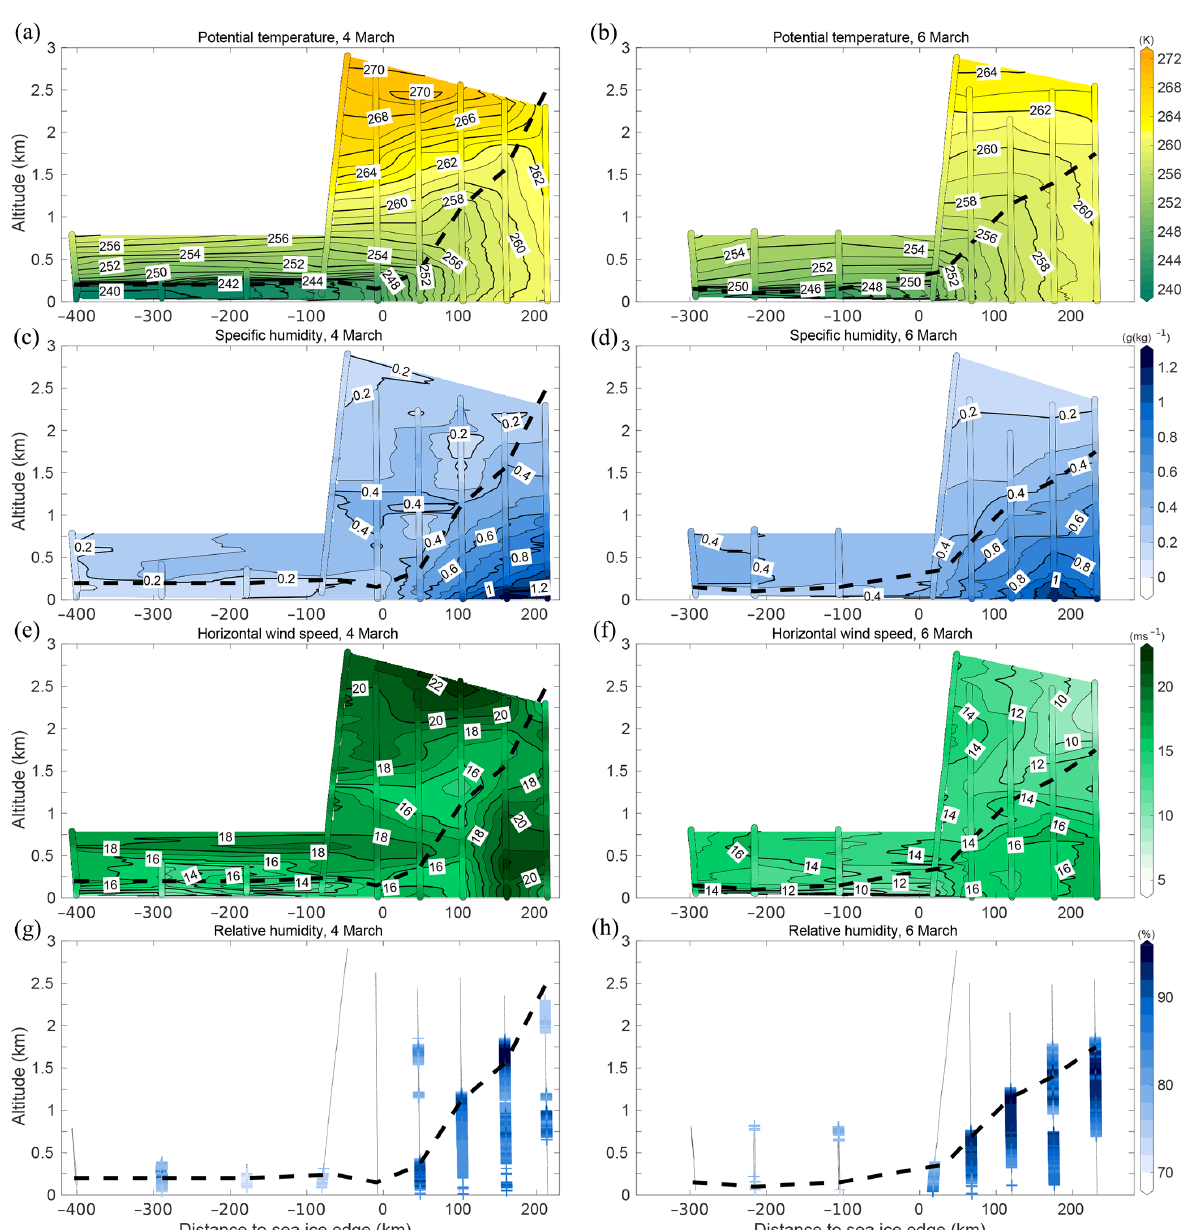
Figure 6. Vertical cross sections of (a–b) potential temperature, (c–d) specific humidity, (e–f) horizontal wind speed, and (g–h) relative humidity in saturated areas with respect to an ice surface for (a, c, e, g) 4 March and (b, d, f, h) 6 March 2013 based on the quality-controlled airborne and dropsonde measurements. The flow is from left to right so that negative (positive) distances correspond to sea ice (open water). Dashed black lines denote the ABL height. Modified based on Tetzlaff et al. (2014) and Tetzlaff